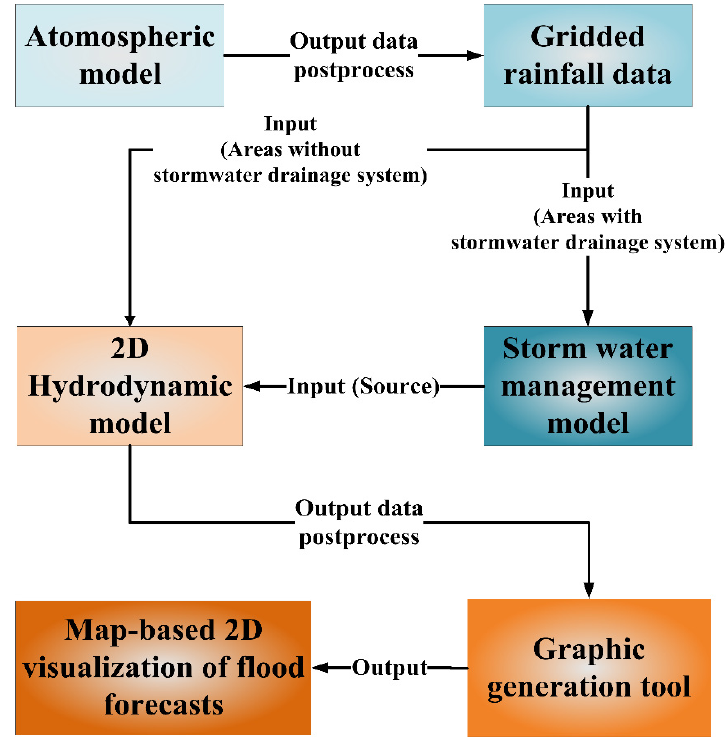
Figure 11. A flow chart and the main components of the operational high-performance forecasting system for pluvial flash floods.